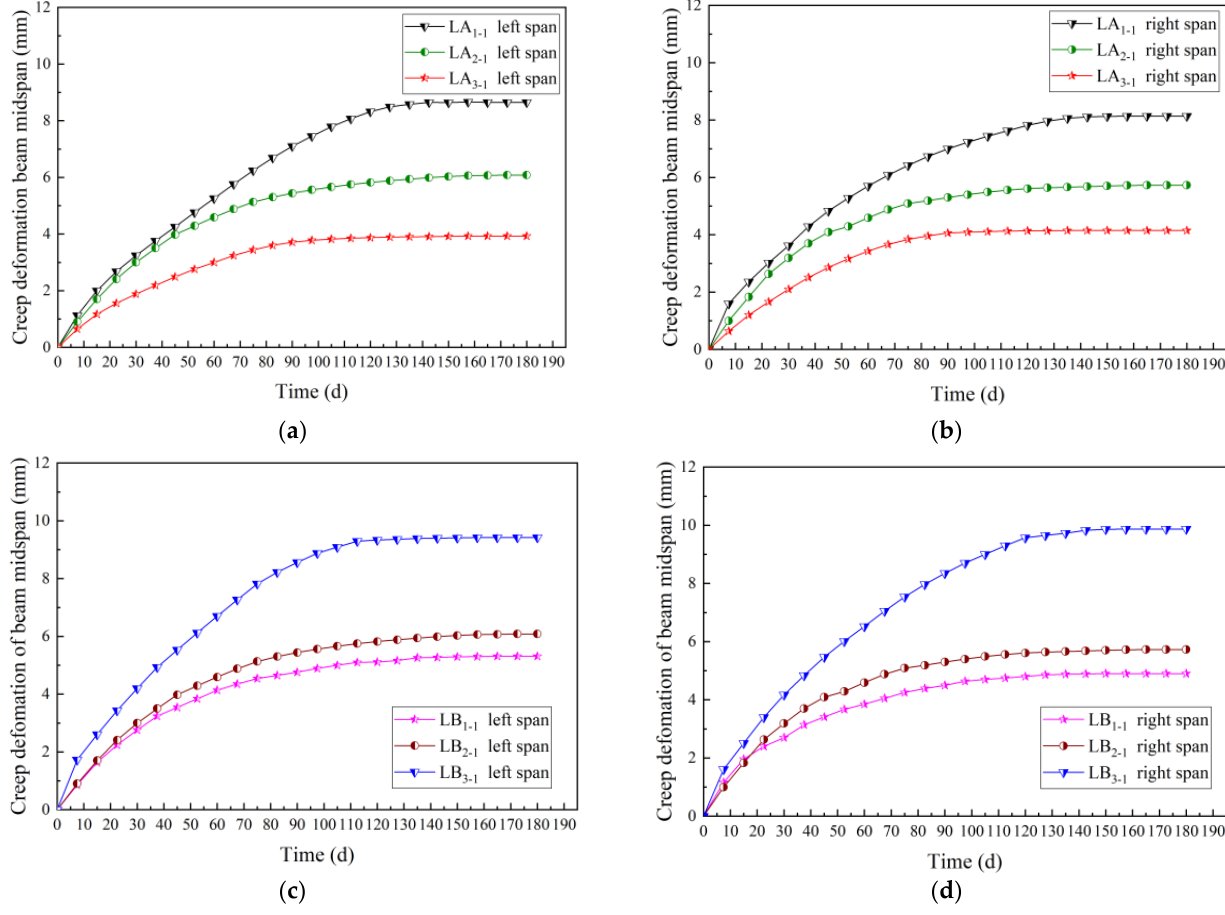
Figure 13. Time-varying curves of the creep deformation: ( a ) left span of group A (different steel wires quantities); ( b ) right span of group A (different steel wires quantities); ( c ) left span of group B (different prestress values); ( d ) right span of group B (different prestress values).